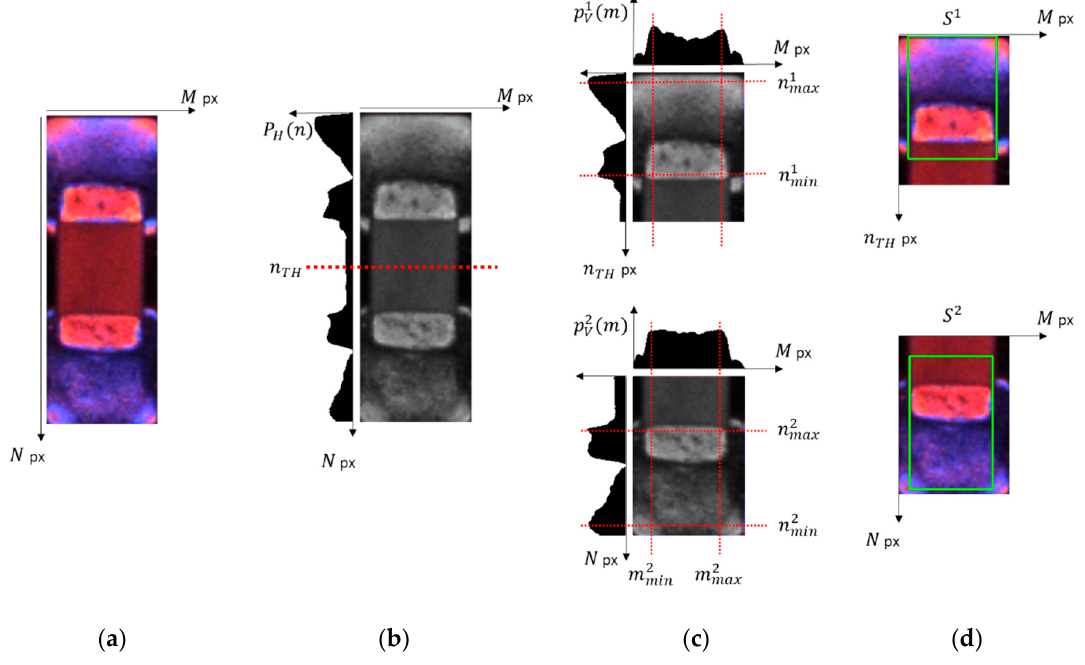
Figure 8. Solder region extraction of SMT chip image where ‘px’ refers to pixels: ( a ) chip component image, ( b ) gray scale image showing horizontal split of chip component, ( c ) vertical and horizontal projections, and ( d ) result of solder region